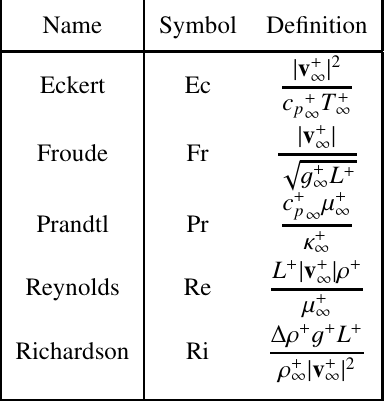
Fig. 1. Example of decaying spectra on a single triangular ele- ment for 2D polynomial expansion of degree N = 14. Spectral coe ffi cients ˆ f pq are only those with index p + q < = N in the graph. Green ellipses show the maximal degree coe ffi cients whose sum provides heuristical error estimate. For this case, one can con- clude, that the spatial approximation is not better than 10 − 8